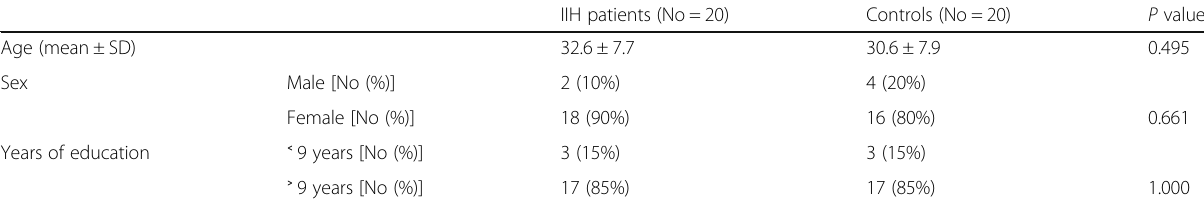
Table 1 Demographics of IIH patients and controls